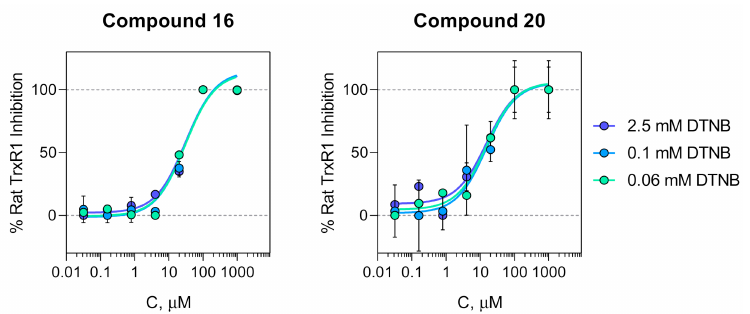
Figure 7. TrxR1 inhibition in rat liver extracts.